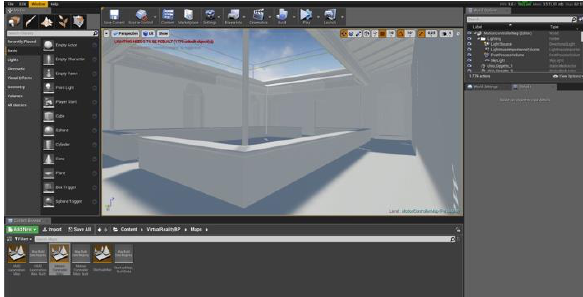
Figure 10. 3D model of the Cloister of the Prior imported within Unreal Engine.